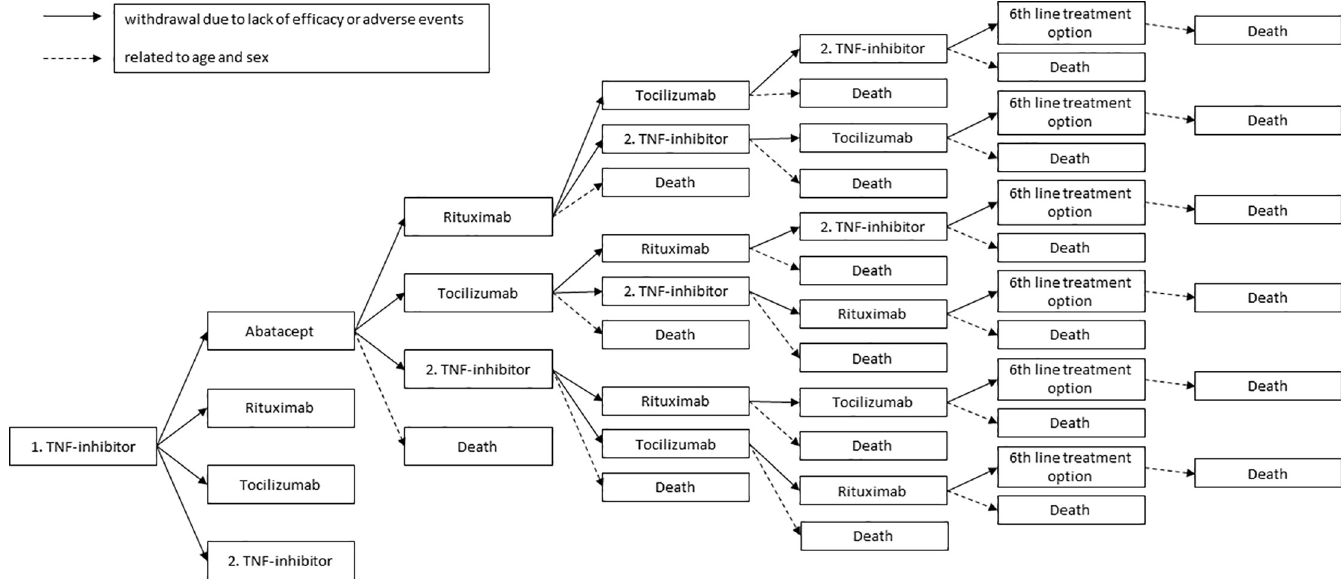
Fig 1. Treatment pathways included in the model. The pathways for rituximab, tocilizumab and TNF-inhibitors follow identical logic as for abatacept. DAS28 = Disease Activity Score 28, HAQ = Health Assessment Questionnaire, TNF inhibitor = tumor necrosis factor inhibitor.